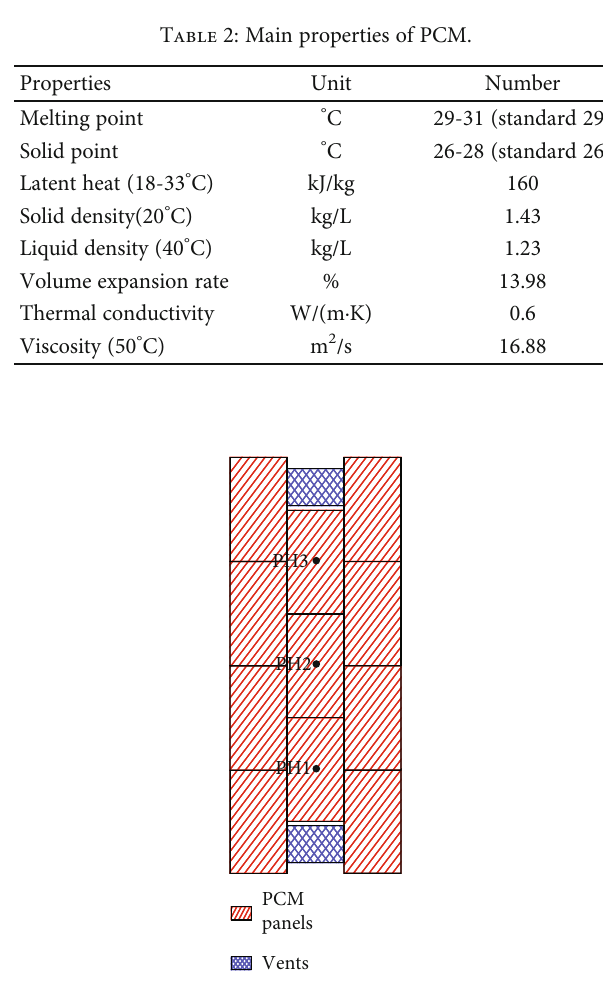
Figure 3: Distribution of phase change board and the thermocouples. Table 3: Uncertainty of sensors at test